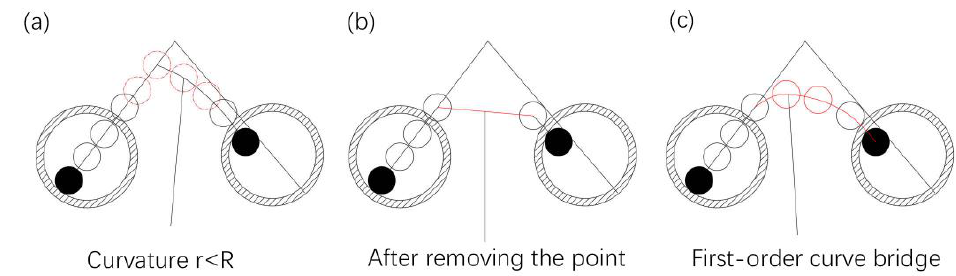
Figure 16. The principle of removing points at the corner. ( a ) Track points that make up the curve whose curvature radius is less than R min , ( b ) track after removing the points, causing the track curvature radius to be less than R min , ( c ) first-order transition curve replaces the removed the points. The approximate calculation method of the curvature radius for the fiber track is shown in Figure 17. The continuous points ( x f − n , y f − n ) → ( x fn , y fn ) around the current fiber point ( x f 0 , y f 0 ) are fitted. In order to reduce the fitting error, an eighth-order polynomial is applied for calculation. The calculation formula is shown in Equation (2):